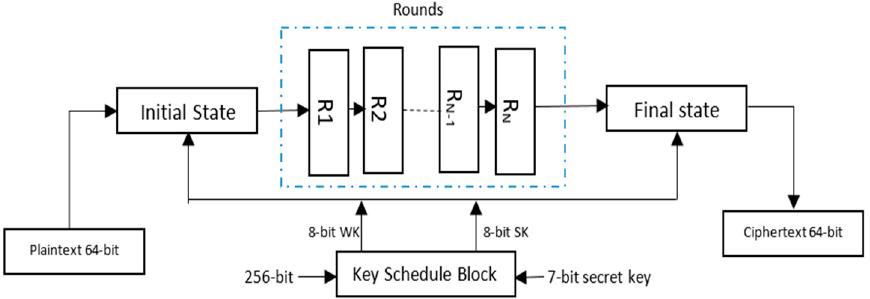
Figure 4. Structure of the modified cryptosystem. wk: work key, sk: sub key.